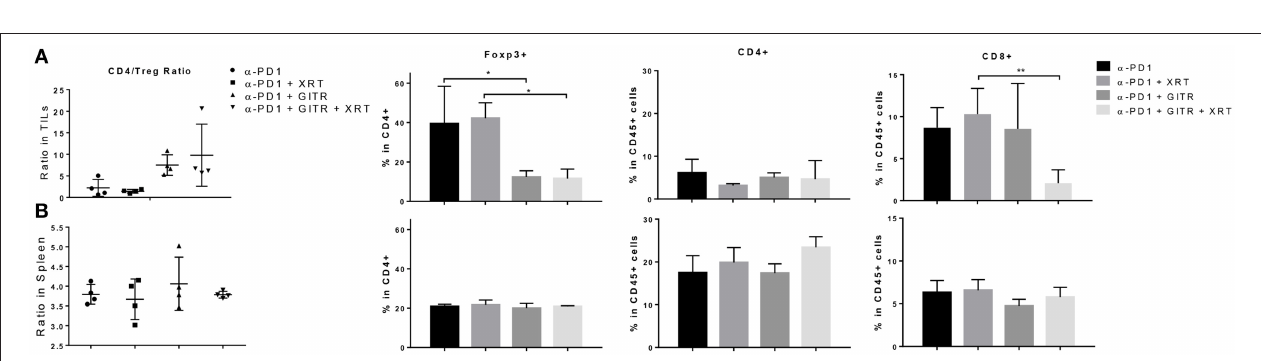
FIGURE 4 | Anti-GITR therapy reduces regulatory T cells and increases the CD4 / Treg ratio at the tumor site but not in the spleen. Immune cells isolated from murine tumors were phenotyped 22 days after tumor inocluation. (A) Tumor-infiltrating leukocytes (TIL) and (B) splenocytes were isolated and evaluated for CD4, CD8, and Foxp3 expression. Foxp3 + values are shown after gating from within CD4 + cells. The CD4 + Foxp3– values were divided by the CD4 + Foxp3 + values to display the ratio. * P ≤ 0.05 in Student t